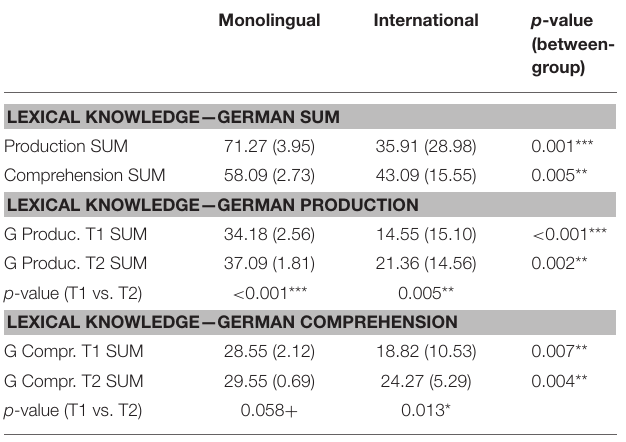
TABLE 1 | Means and standard deviations in parentheses for lexical knowledge of groups per skill for German.